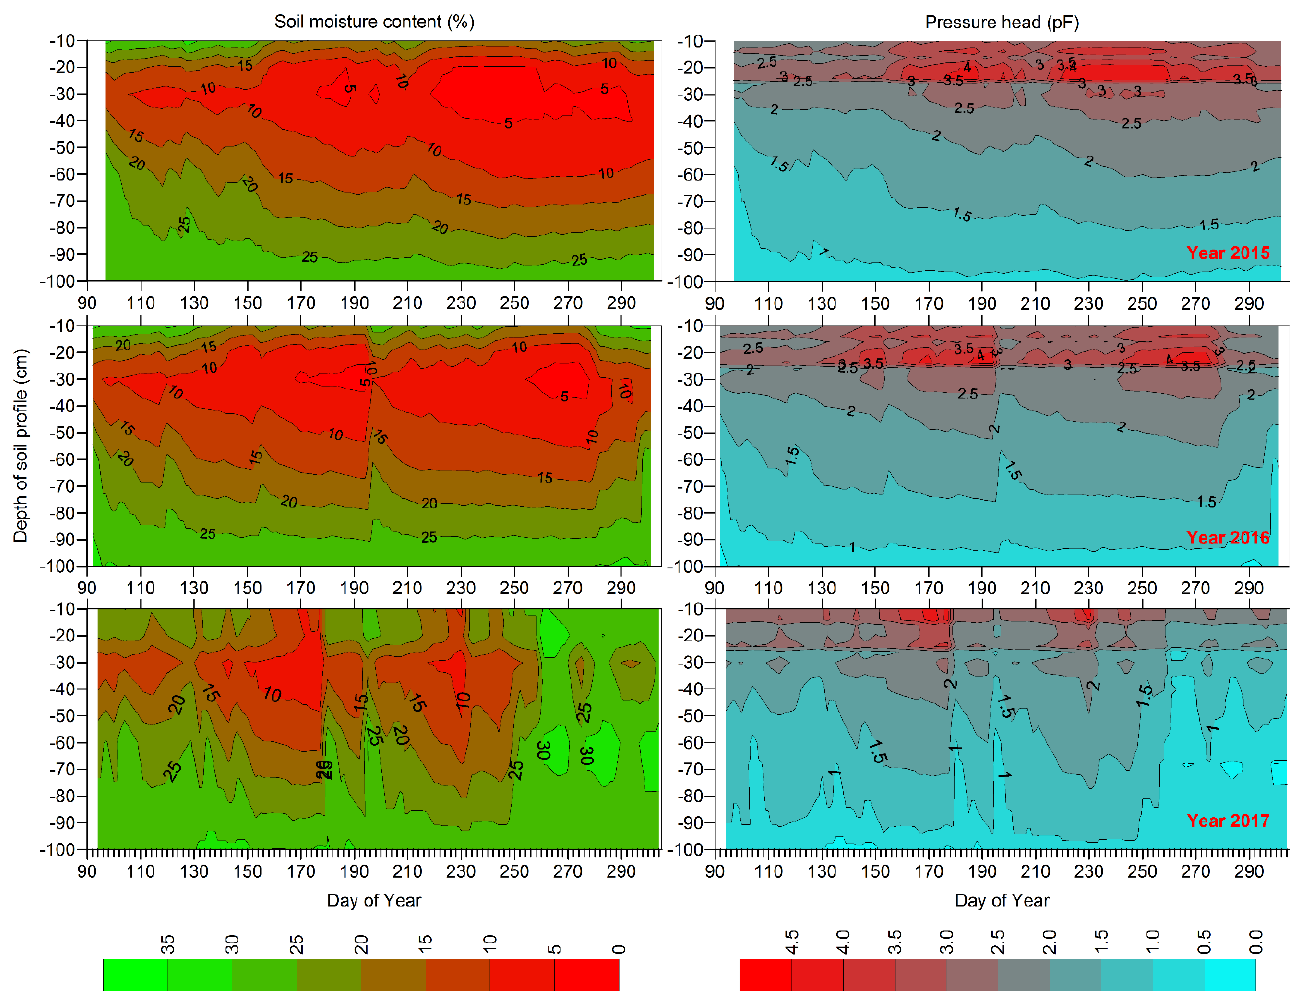
Figure 9. Spatiotemporal distributions of soil moisture content and pressure head in vegetation periods 2015, 2016, and 2017.